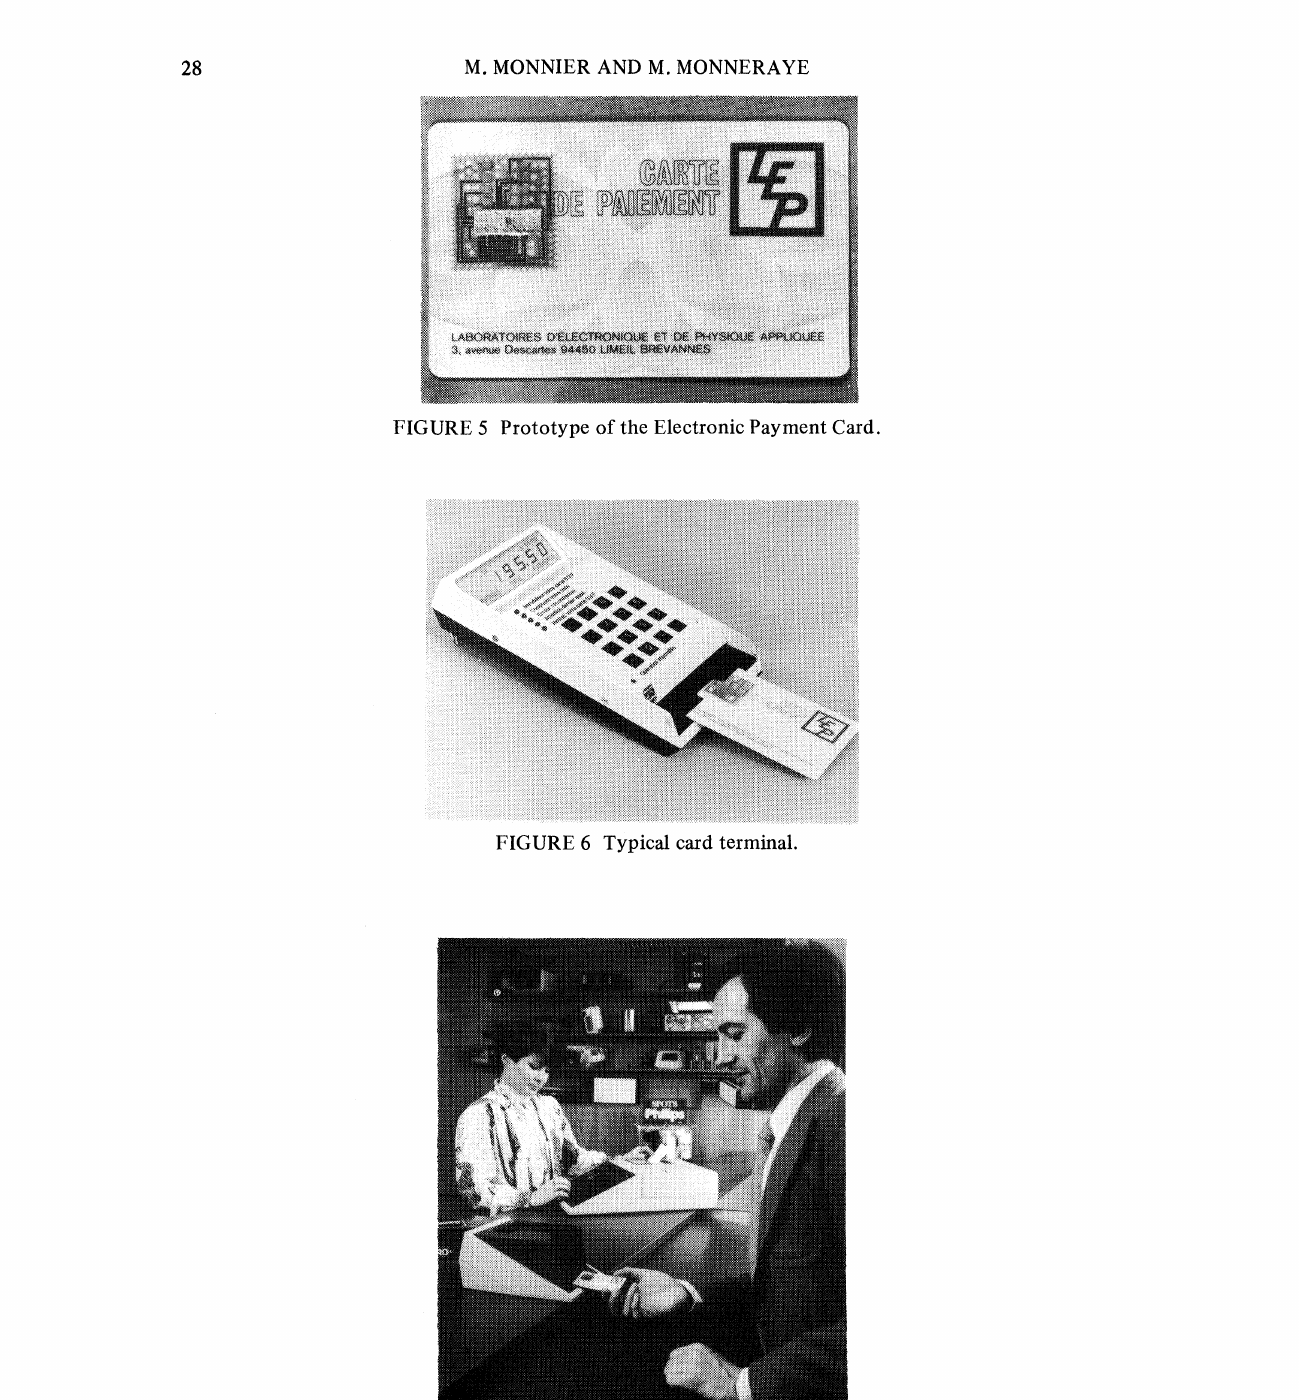
FIGURE 7 Typical transaction